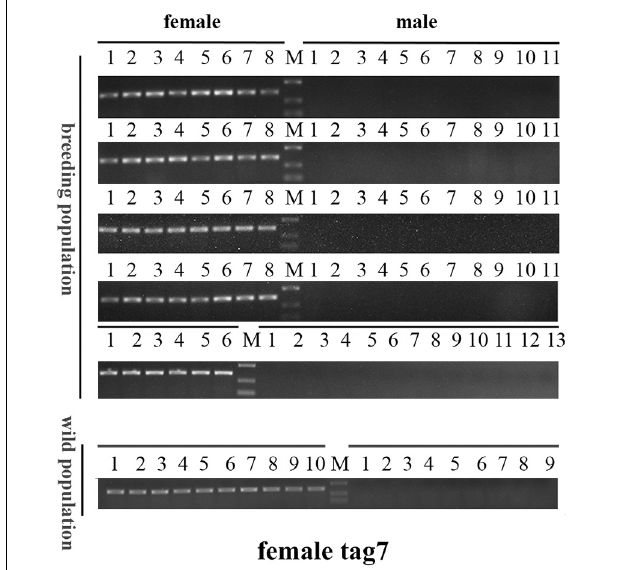
FIGURE 7 | Electrophoretogram of the amplified products using female-tag 7 for genotypic sex identification in M. nudus. Label M represents the DL2,000 DNA marker (500 and 250 bp DNA ladder are shown).